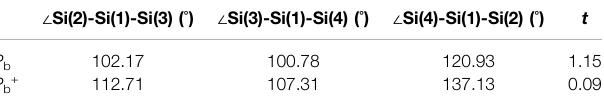
TABLE 1 | Three Si-Si-Si bond angles and the parameter